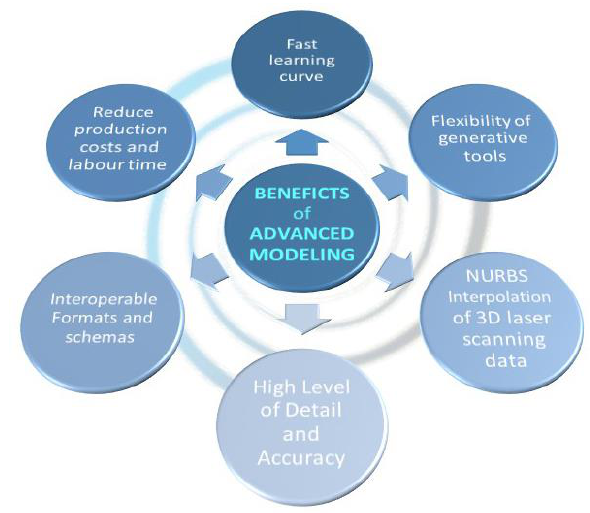
Fig. 2. Benefits of Advanced Modeling for complex BIM